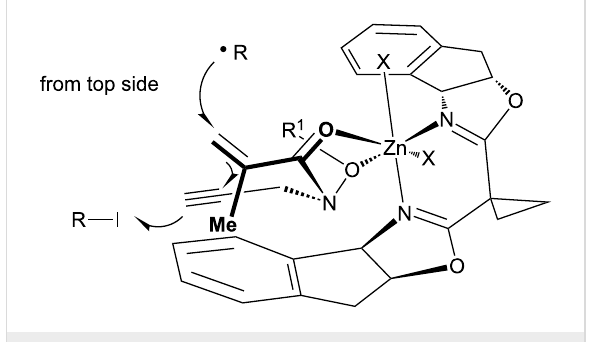
Figure 5: Model for the enantioselective reaction.